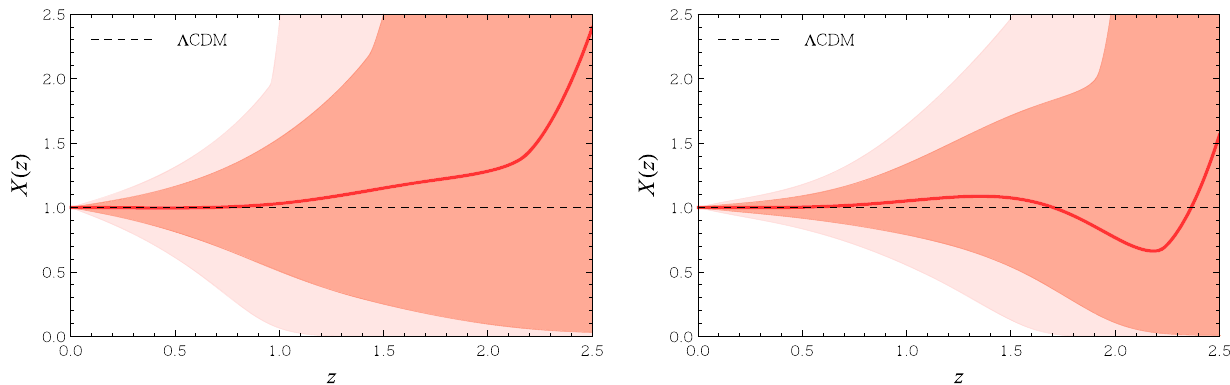
Fig. 7 X ( z ) vs z with 1 σ and 2 σ CL regions, reconstructed from SN+BAO+CC data (left panel) and SN+BAO+CC+H0LiCOW data (right panel). The dashed black curve corresponds to (cid:4) CDM model prediction X =